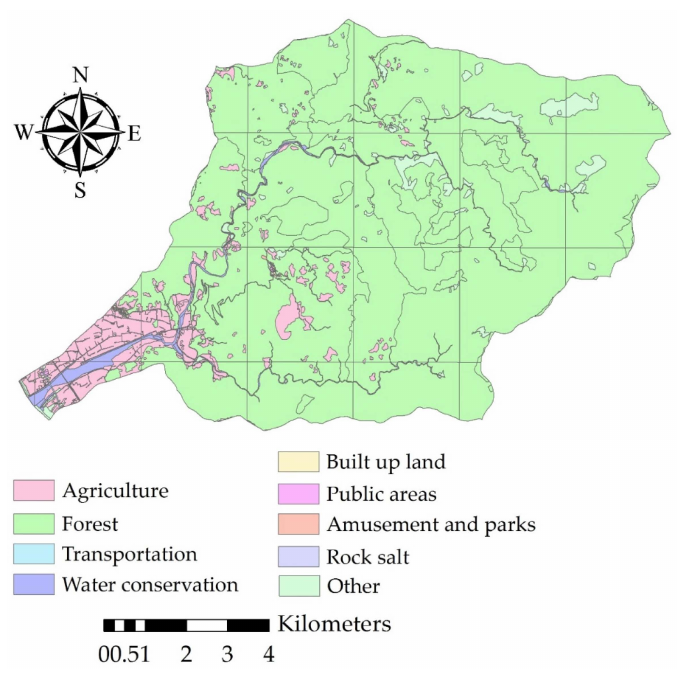
Figure 2. Land use map for the Shiwen